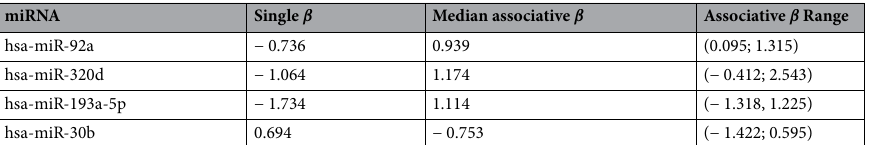
Table 4. Single (i.e. the estimated value of a β coefficient when considering a single miRNA in the logistic model) and associative (i.e. the different values that a miRNA specific β coefficient takes in each of the SWAG models in which it is present) coefficients (median values and range) for the antagonistic miRNAs present in at least 10% of the models. Associative ranges and not confidence intervals are shown since some of the coefficients display a bi-modal